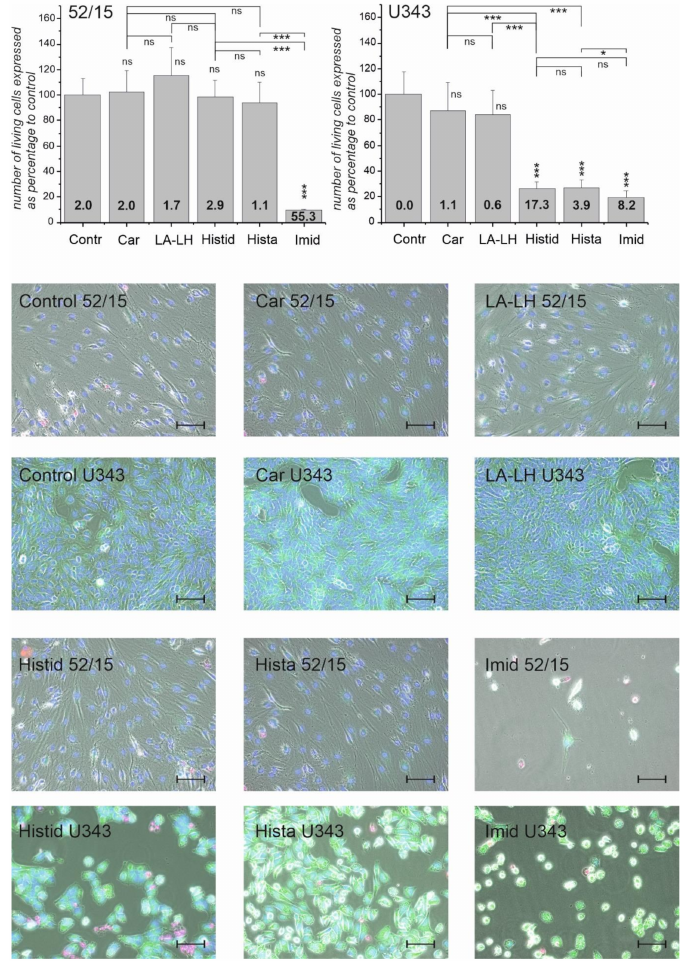
Figure 2. Microscopic analysis of fibroblasts (52/15) and glioblastoma cells (U343) in the presence of different compounds. Cells were treated for 48 h with carnosine (Car), L -alanyl- L -histidine (LA-LH), β -alanyl- L -alanine ( β A-LA), L -histidine (Histid), histamine (Hista), imidazole (Imid), L -alanine (LA), and β -alanine ( β A) (all 50 mM) or vehicle control (Contr) for 48 h. Then, microscopic images after staining with Hoechst 33343 (nuclei, blue), propidium iodide (dead cells, red), and Calcein-AM (living cells, green) were compared (representative images are presented as overlays in the lower panels, which also include an image obtained by phase contrast). In order to determine the number of living cells using ImageJ, the total number of nuclei was determined, subtracting the nuclei of dead cells (bars in upper panel; note: determination of living cells from images of cells positive for Calcein-AM staining was not performed because of high errors due to technical reasons). The ratio of dead cells to living cells is presented by bold numbers in the bars in the upper panel. Statistical analysis was performed using a one-way ANOVA. The level of significance between different compounds is indicated by horizontal lines and compared to Contr above the bars: *: p < 0.05; ***: p < 0.0005; ns: not significant. (Size bars: 100 µ